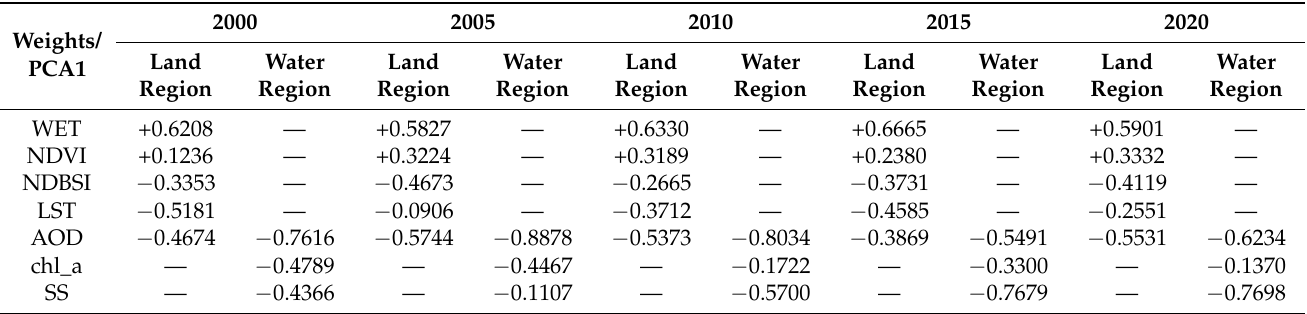
Table 2. Weights of